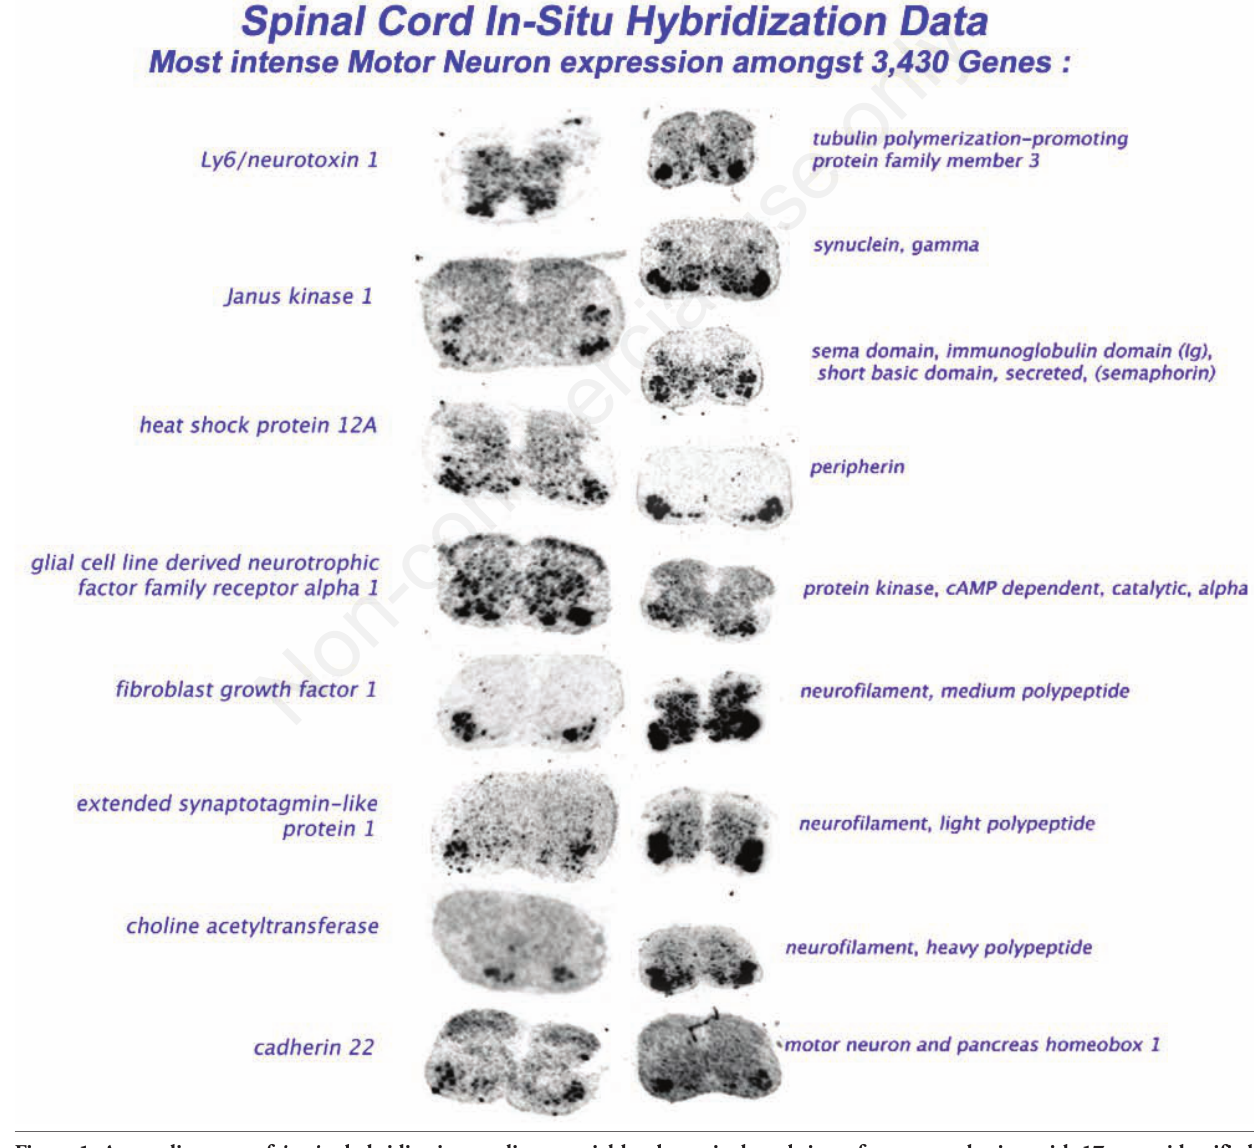
Figure 1. Autoradiograms of in-situ hybridization studies on axial lumbar spinal cord tissue from normal mice, with 17 genes identified as showing the most selective and intense gene localizations to the anterior horn of the spinal cord; images from the original on-line GEN- SAT atlas were enlarged and then had the gray scales inverted to produce the above illustration style against a clear